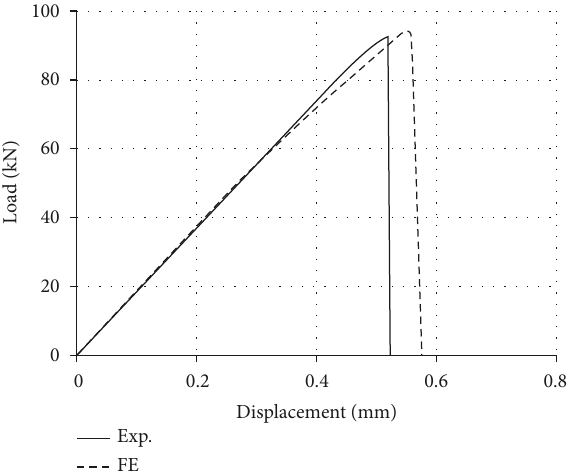
Figure 12: Comparison between experimental and FE load vs. displacement curves for specimen